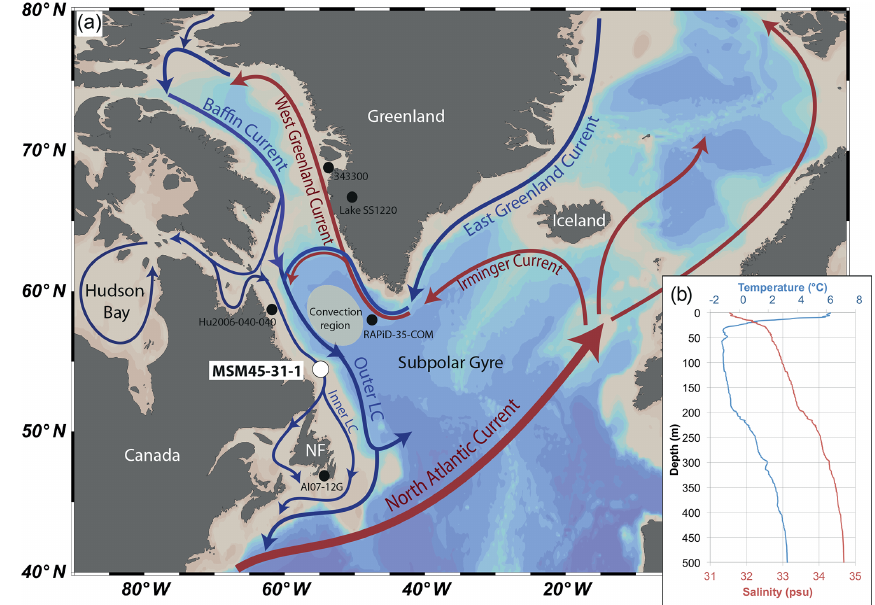
Figure 1. (a) Map of the North Atlantic showing modern surface circulation with cold (blue) and warm (red) currents (adopted from Lazier and Wright, 1993; Rhein et al., 2011). A shaded area indicates the convection region of LSW. Core MSM45-31-1 is marked by a white dot; other cores referred to are marked by black dots. NF: Newfoundland. (b) Depth profiles of temperature (blue) and salinity (red) of the water column near the core site at 54 ◦ 28.53N, 56 ◦ 04.33W obtained from CTD deployment during cruise MSM45 in August